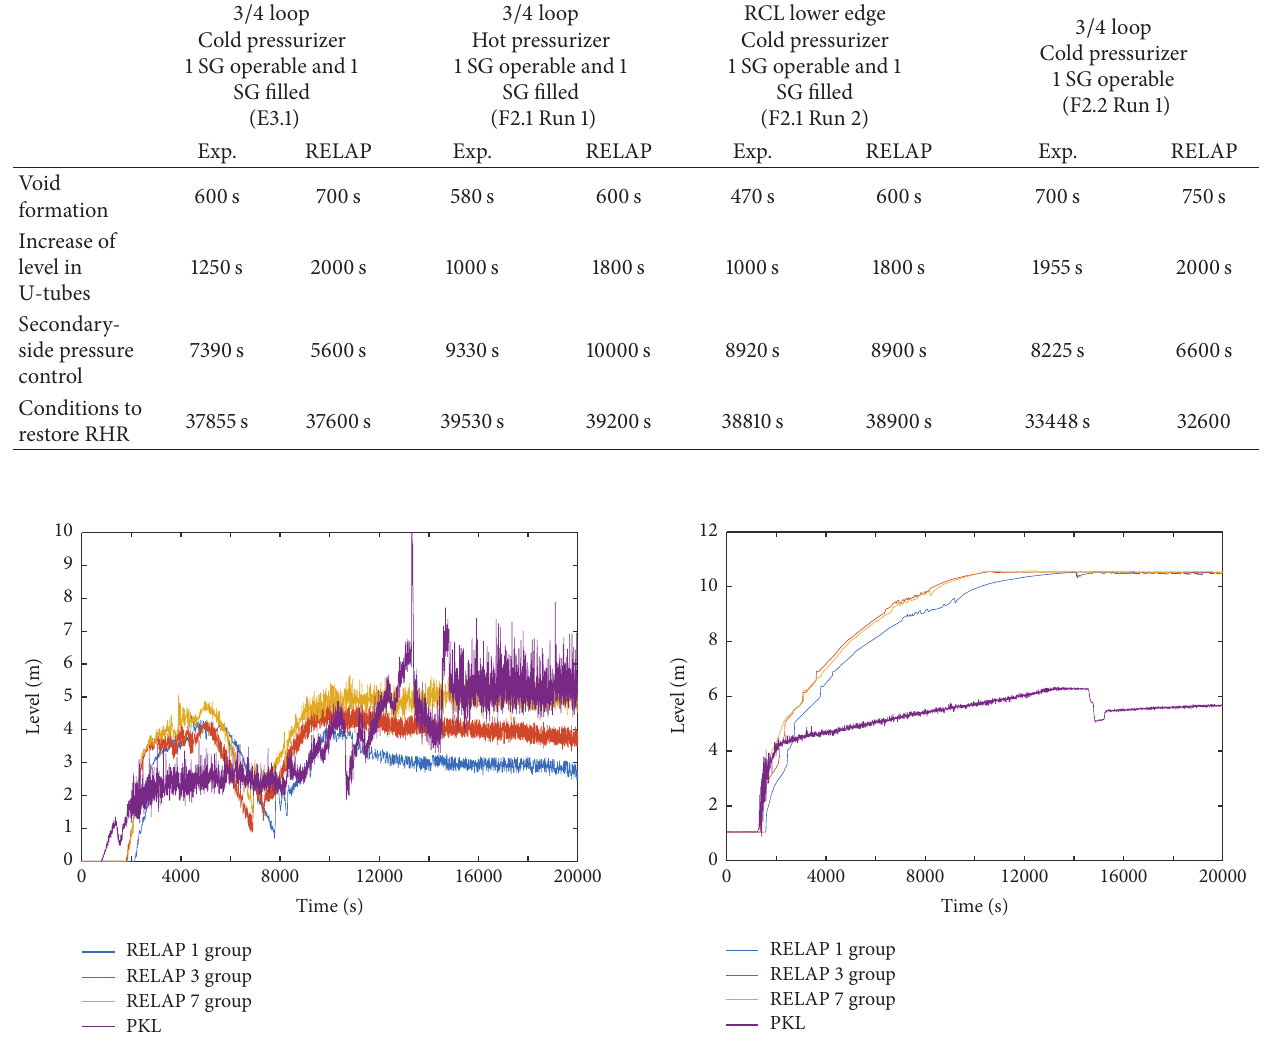
Figure 17: SG 1 level 1, 3, and 7 groups. Figure 18: Pressurizer level 1, 3, and 7